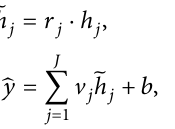
Te automatic scram prediction model based on LSTM